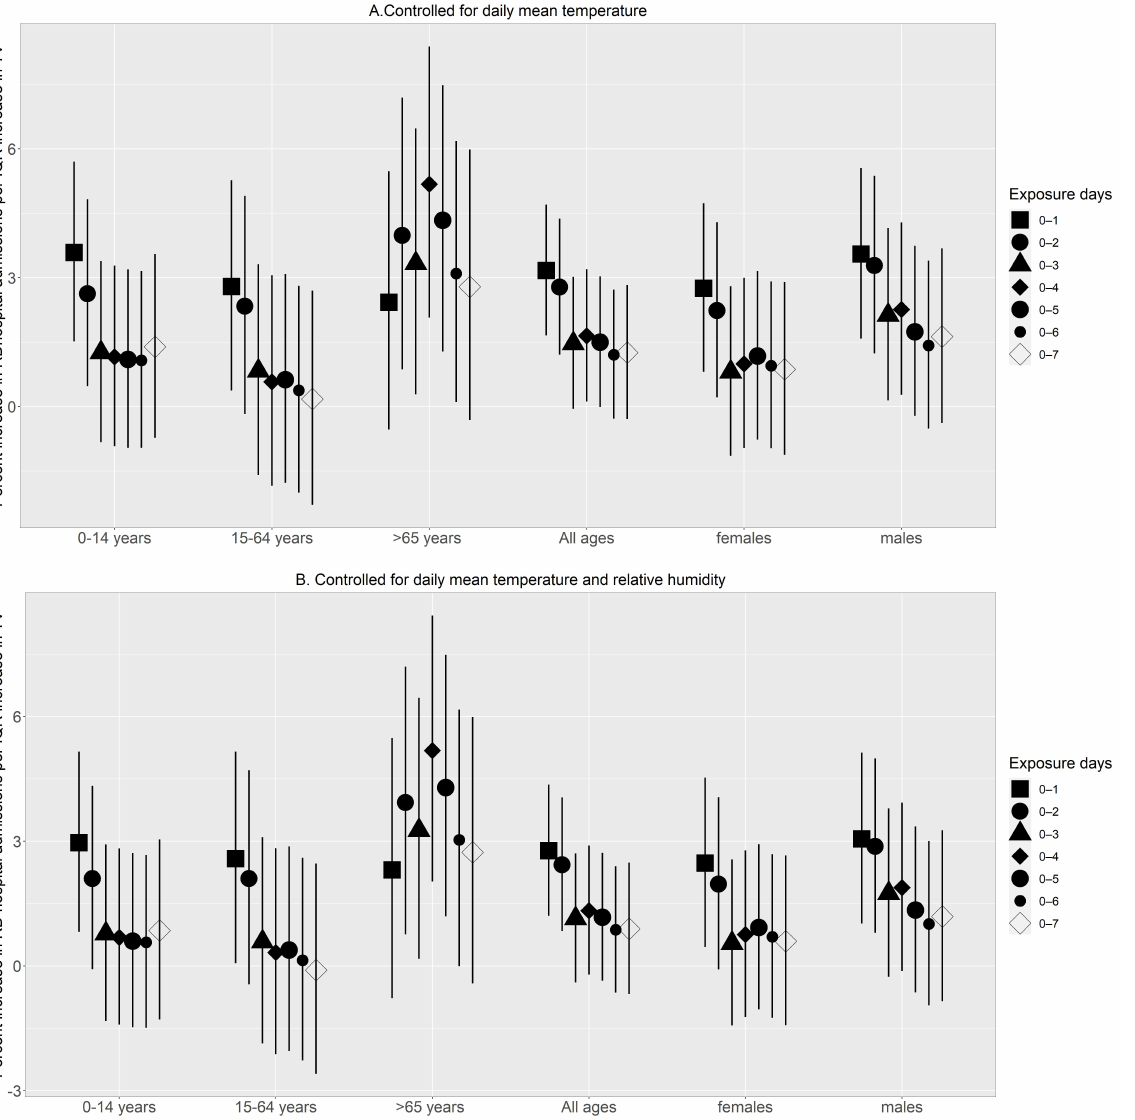
Figure 4. Percent change (95% confidence interval) in respiratory disease hospitalisation associated with an interquartile increase in temperature variability (°C) on different exposure days: ( A ) After controlling for day of the week, time, and seasonal trends and daily mean temperature. ( B ) After controlling for the day of the week, time, and seasonal trends and daily mean temperature and relative